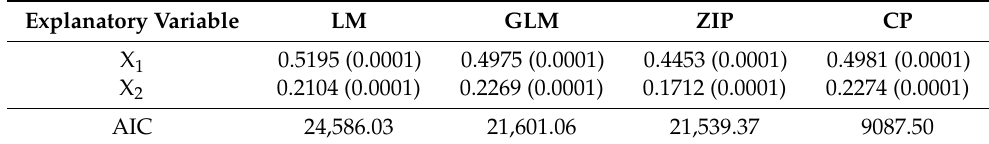
Table 3. Analysis results of comparative models using simulation data. Explanatory Variable